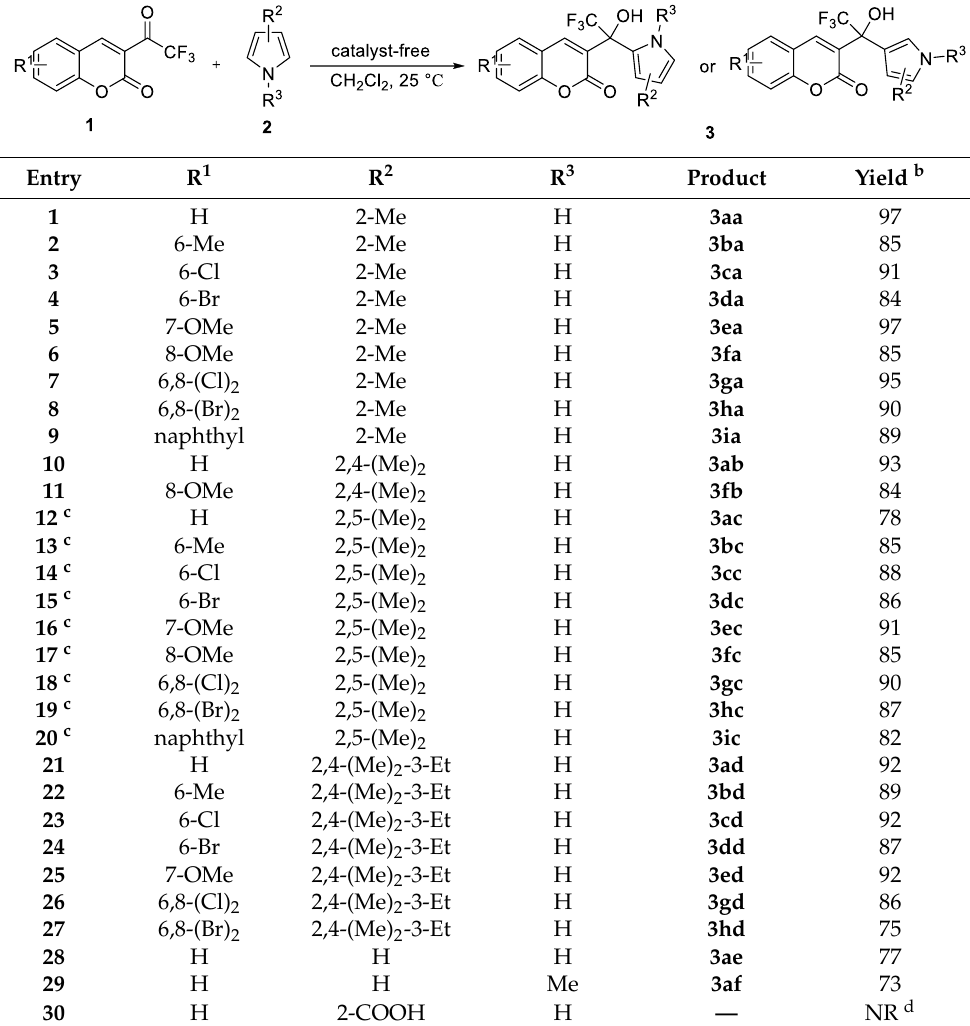
Table 2. Reaction scope of the Friedel – Crafts reaction of 3-(trifluoroacetyl)coumarin 1 with pyrroles 2 a .